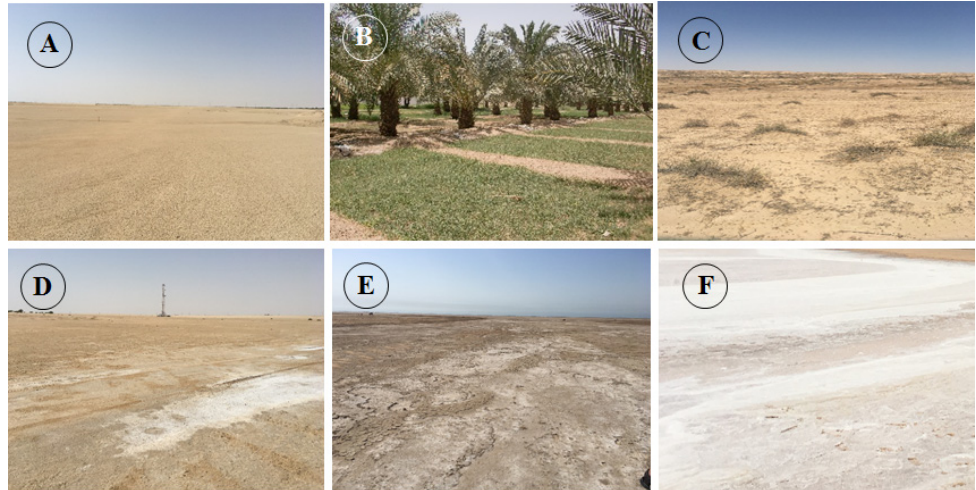
Figure 3. Photos illustrating the six considered soil salinity classes: non-saline ( A ), low ( B ), moderate ( C ), high ( D ), very high ( E ), and extreme salinity, which is sabkha ( F